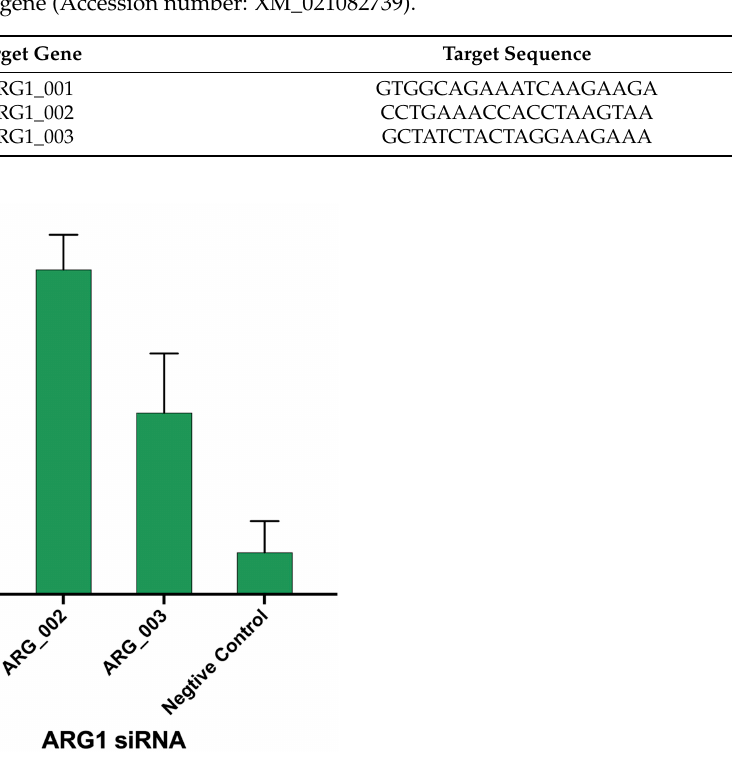
Figure 10. Test for ARG1 siRNA knock-down efficiency. Three siRNAs targeting ARG1 were transfected into PAM cells, respectively, and cell samples were collected 3 days later; the mRNA level of ARG1 was detected, and then the knockout efficiency of ARG1 for each siRNA was calculated.